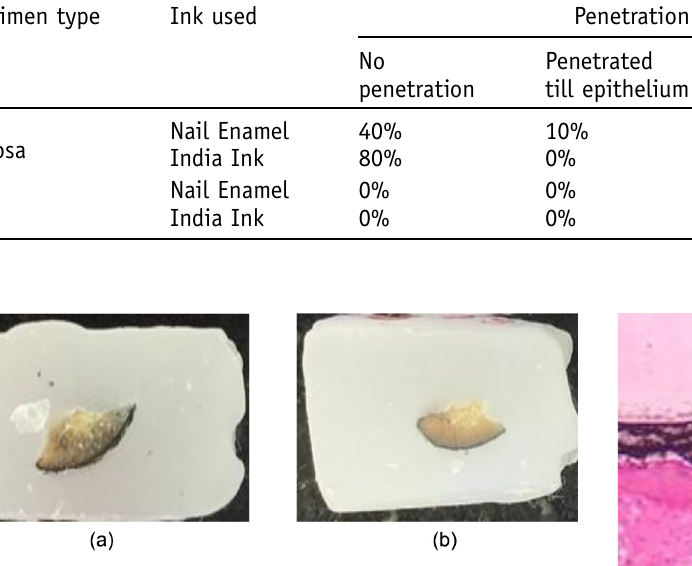
Fig. 2. Visibility of ink on wax blocks. (A) Inked with nail enamel, (B) Inked with India ink.